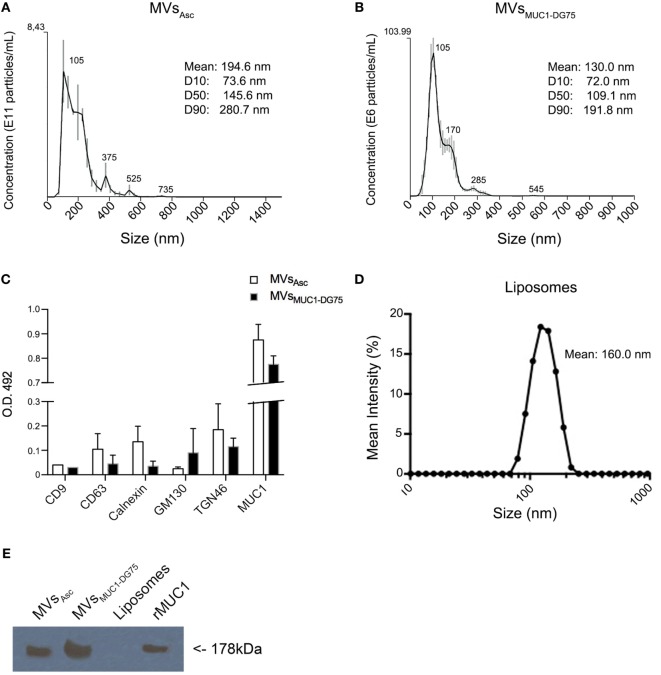
Characterization of tumor-derived microvesicles (MVs) and Liposomes. (A,B) Size measurement of MVs derived from ovarian cancer ascites fluid [MVsAsc; (A)] and shed by the MUC1-transfected DG75 lymphoblastoid cell line [MVsMUC1-DG75; (B)] using Nanosight NS300 that employs nanoparticles tracking analysis (NTA) technology. Results are plotted as graph; y-axis: concentration of particles; x-axis: size of particles in nanometer. The black curve is obtained by the merge of three independent measurements for each MV sample. SD and the medium sizes of identified vesicle subsets are shown above the merged curve. Legend shows the particle medium size of the entire sample and the dimension of the 10, 50, and 90% of vesicles in the sample (D10, D50, and D90, respectively). (C) CD9, CD63, Calnexin, GM130, TGN46, and MUC1 proteins expression in MVsAsc (white histograms) and MVsMUC1-DG75 (black histograms) as detected by ELISA assay (O.D. 492). Sample ODs were subtracted of the OD values of control samples [MOPC1 and Normal Rabbit Serum (NRS)]. Results are plotted as average and SD of two independent experiments. (D) Liposomes size measurement using Zetasizer Nano ZS90 that employs NTA technology. Results are plotted as graph; y-axis: mean intensity percentage; x-axis: size of particles. The black curve shows the representative Liposomes dimension out of five different size measurements. (E) MUC1 expression in vesicle samples. MUC1 was detected by Western Blot analysis employing the MoAb Ma552. MVsAsc and MVsMUC1-DG75 were positive, while Liposomes were negative. The recombinant MUC1 glycoprotein (rMUC1) was used as positive control.